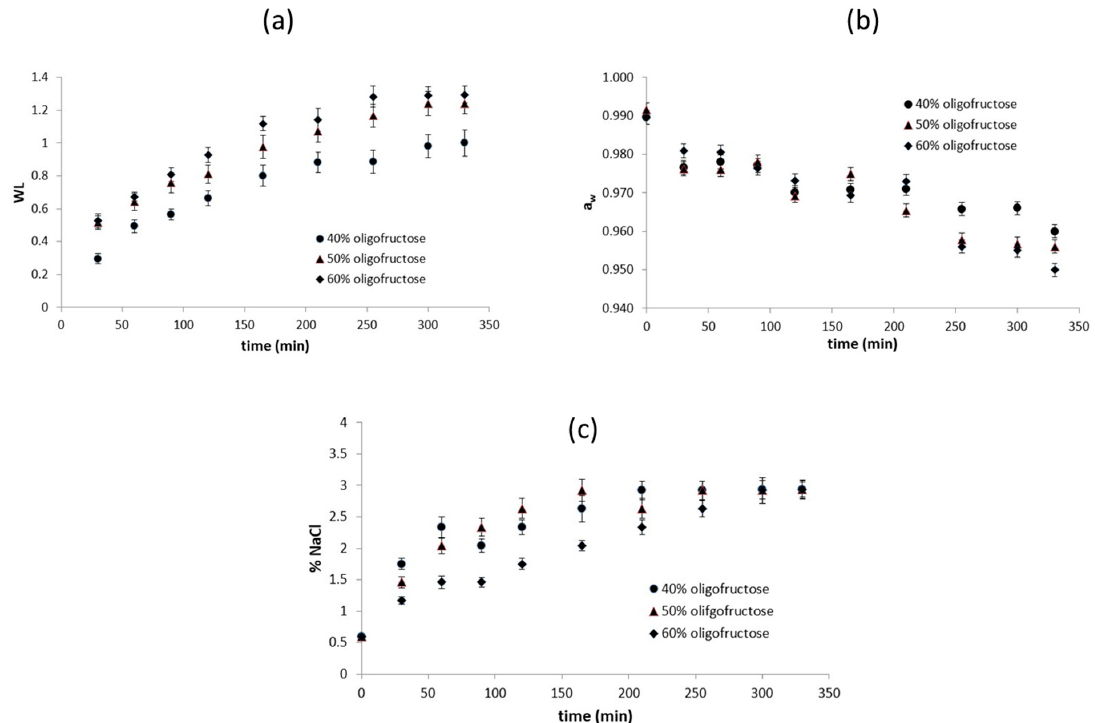
Figure 2. ( a ) Water loss (WL), ( b ) a w decrease, and ( c ) NaCl percentage of fish samples during OT at different concentrations of the osmotic solution. Error bars represent the ± standard deviation of measurements. of